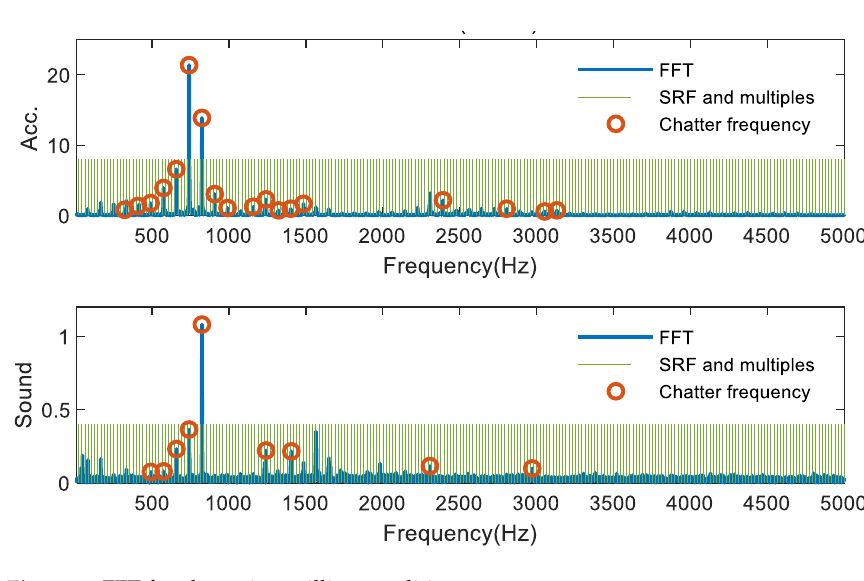
Figure 8. FFT for chattering milling condition.